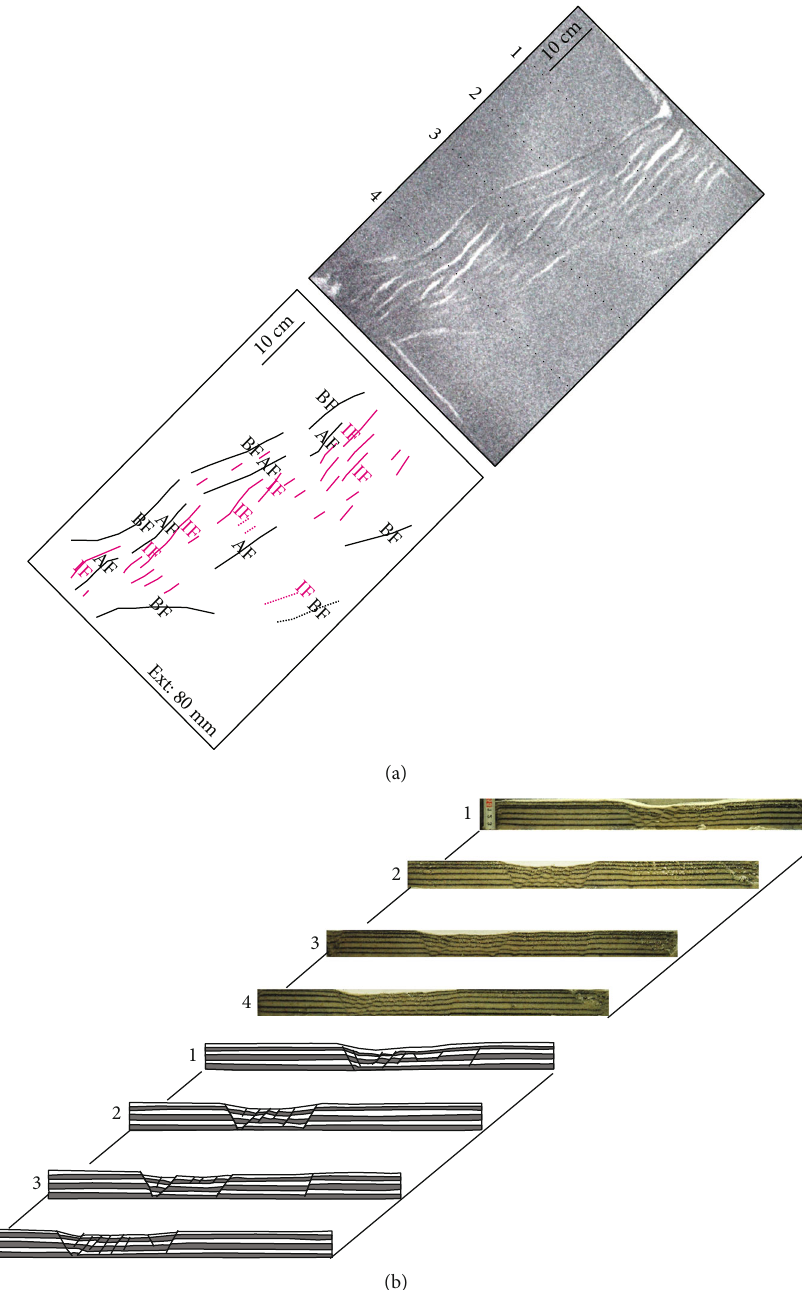
Figure 7: Evolution and characteristics of deformation in model 3, with thicker strata. (a) Top-view photo (upper panel) and schematic line- drawing of structures (lower panel), illustrating boundary faults (BF), antithetic faults (BF), and internal faults (IF). (b) Vertical cross sections corresponding to locations in